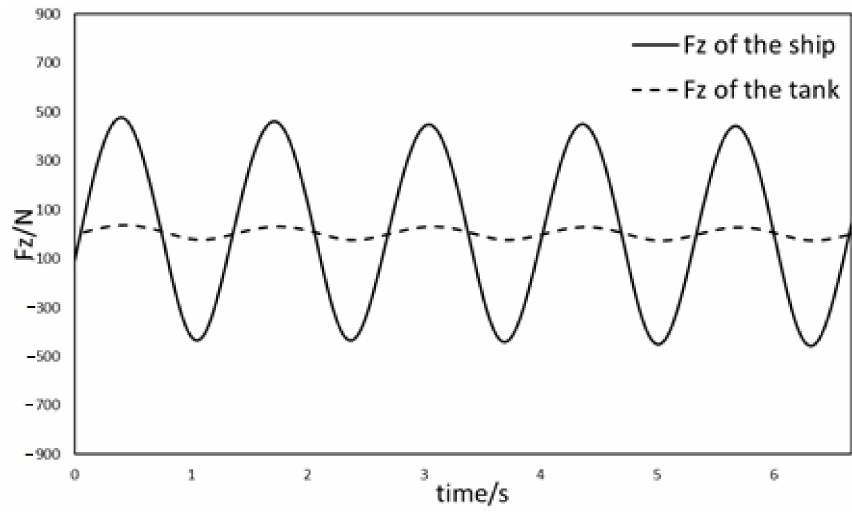
Figure 18. For the ship in beam waves at λ / L = 0.787, time histories of the force in z direction. Figure 19 shows the wave pattern in four different times in the numerical simulation.